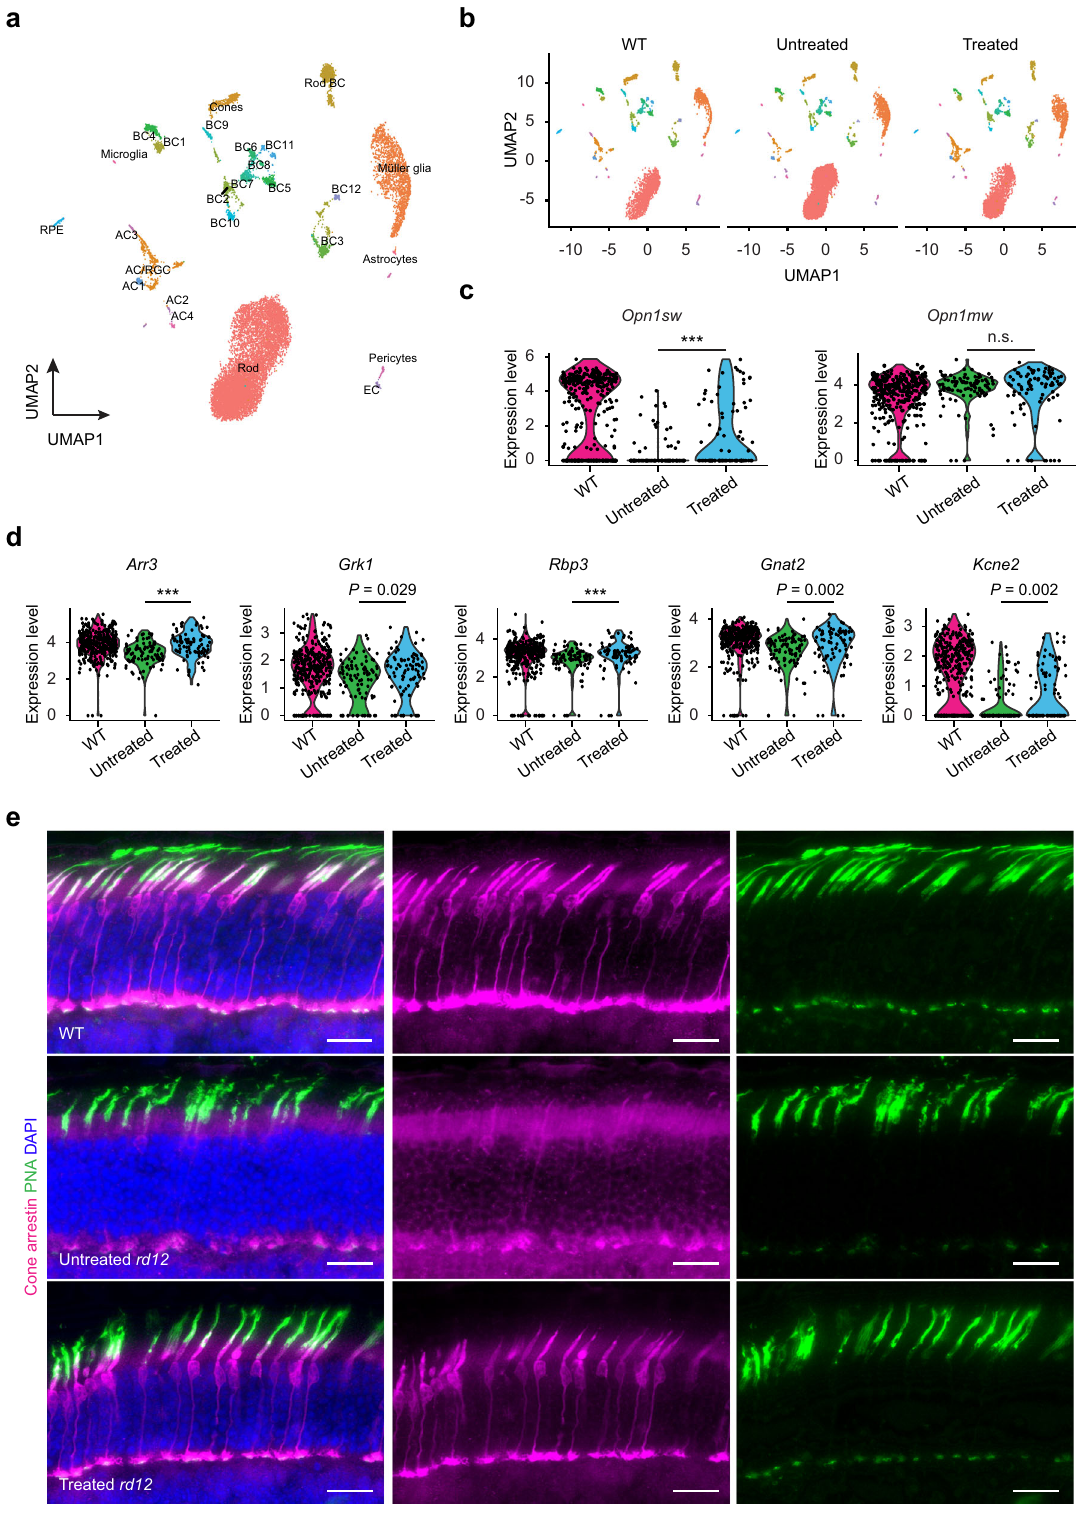
Fig. 6 Single-cell RNA-seq of ABE-treated retinas reveals the rescue of genes associated with phototransduction and cone survival. a Uniform manifold approximation and projection (UMAP) of the single-cell RNA-seq dataset colored by annotated cell type. b UMAP plots showing the distribution of single cells of 2-month-old WT, and untreated and treated rd12 retina samples ( n = 4, each group). c Violin plot pro fi les of S-opsin ( Opn1sw ) and M-opsin ( Opn1mw ) expression levels in individual cone cells. d Violin plot pro fi les of cone phototransduction-associated expression levels in individual cone cells. *** P < 0.001; two-tailed Wilcoxon rank-sum test in Seurat. P values for c , d are provided in Supplementary Table 1. e Retinal cryosections showing the expression of cone-arrestin (purple) in 2-month-old WT, and untreated and treated rd12 mice. Cone cells are labeled with peanut agglutinin (PNA; green). DAPI, blue. Scale bar, 20 μ